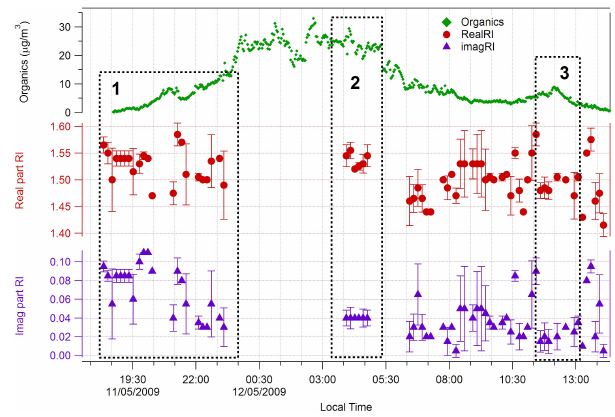
Fig. 12. Time series of the Real and imaginary components of the effective broadband refractive index (EBRI). The total organic mass is plotted to serve as a reference point. The burning event began at around 18:00h local time. Period 1 is mostly open fires, Period 2 smoldering phase, and Period 3 is during the peak of photochemical